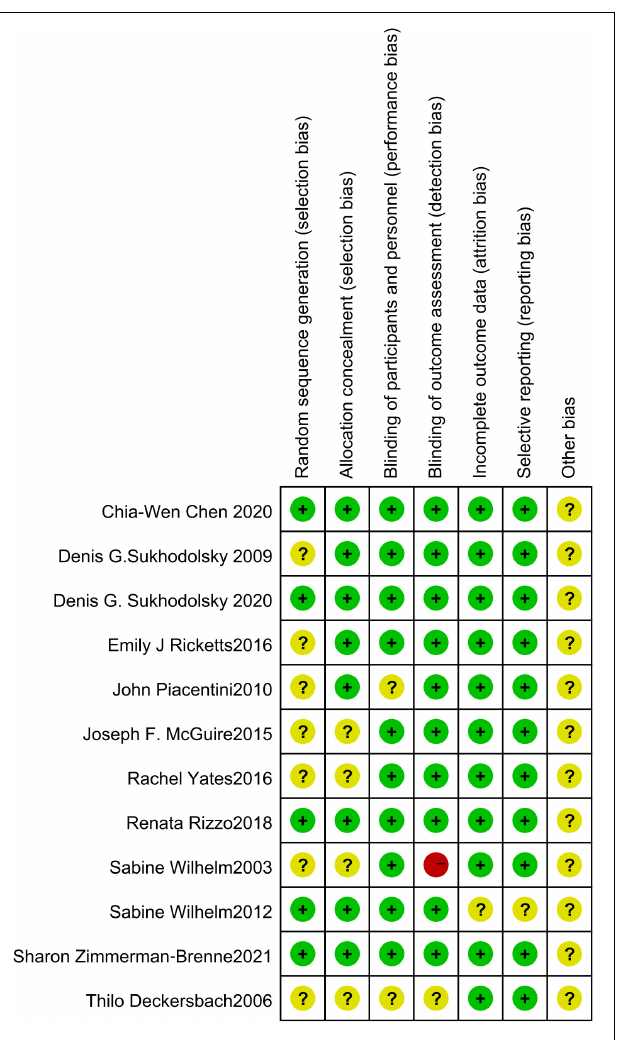
FIGURE 3 | Risk of bias in individual studies. +, low risk of bias; ?, unclear risk of bias; –, high risk of